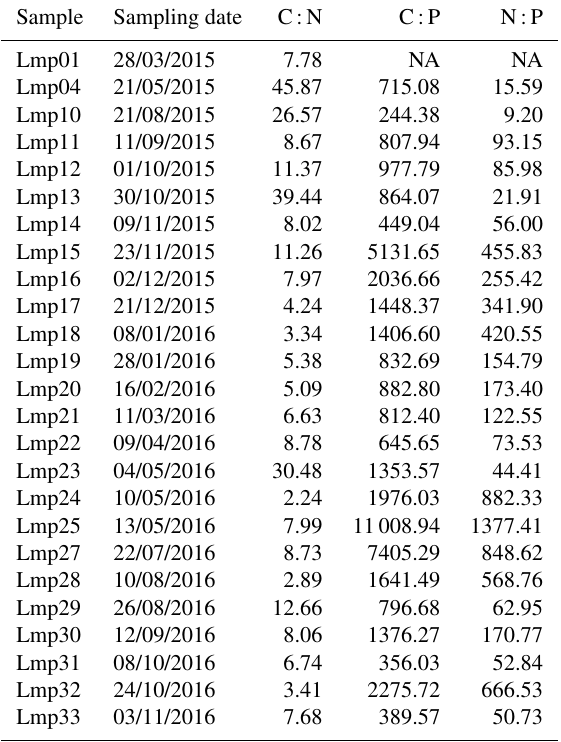
Table 3. C:N:P molar ratios in atmospheric